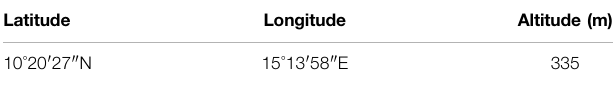
TABLE 1 | Geographical coordinates of the study site (Yagoua town) (Dadjé et al., 2017). Latitude Longitude